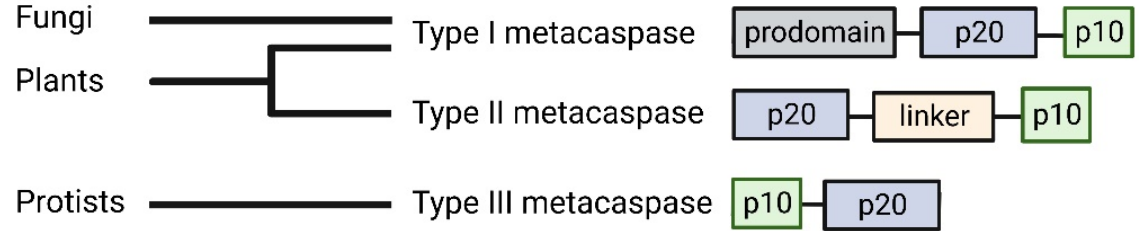
Figure 1. Type I metacaspases share structural similarities to caspases in that they contain an N- terminal prodomain (grey) which also includes proline-rich repeats and zinc finger motifs. Type II metacaspases lack a prodomain and contain a linker (light orange) over five times longer than caspases between the p20 (blue) and p10 (green) subunits [15,19]. Type III metacaspases have been found in phytoplankton and are characterized through the inverted sequential organization of the active subunits, with the p10 subunit situated closer to the N-terminus than the p20 subunit [15,20]. Created on BioRender.com on 6 December